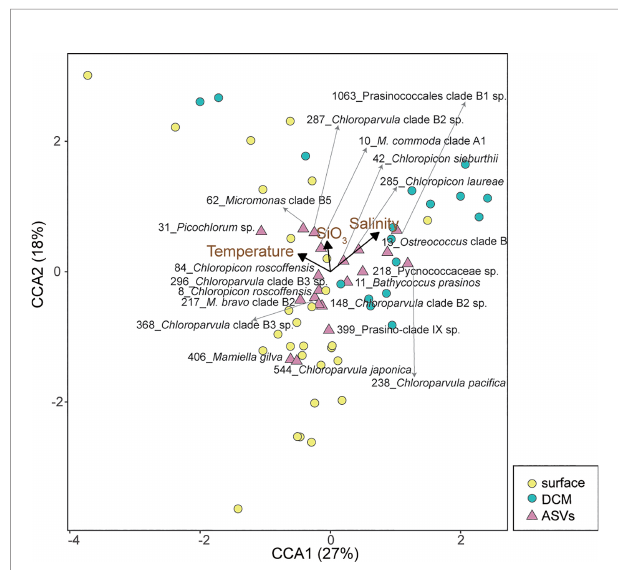
FIGURE 7 | Canonical correspondence analysis (CCA) biplot illustrating the relationship between environmental variables and abundant chlorophyte ASVs. The arrows show signi fi cant environmental variables, the pink triangles represent the 20 most abundant chlorophyte ASVs, and the yellow and turquoise circles represent the surface and DCM samples, respectively. The CCA results show that salinity, temperature and silicate concentration are the most signi fi cant factors driving the chlorophyte communities. The numbers next to the taxonomic annotations indicate the